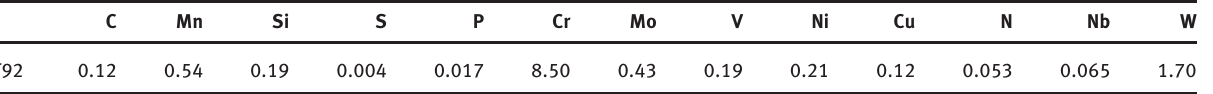
Table 1: The nominal composition of experimental